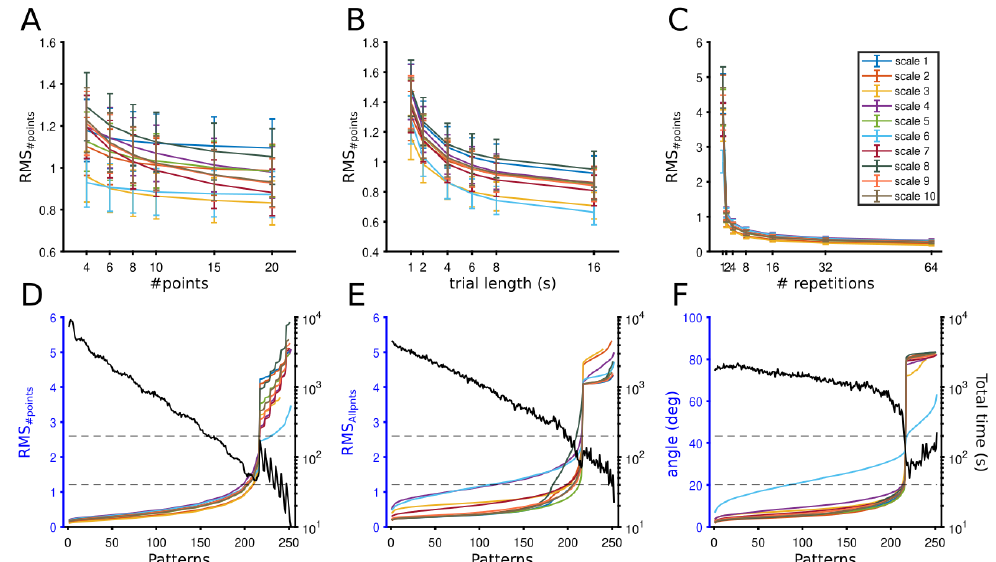
Figure 4. Optimization of fit performance and total experimental time to experimental conditions across metrics (errors). Fit performance as a function of experimental conditions is shown in ( A – C ). Each dot is the average of 300 CRF simulations. Bars represent SEMs. ( A ) RMS #points for a number of points. ( B ) RMS #points for the length of trials. ( C ) RMS #points for a number of repetitions. Sorting of RMS #points ( D ), RMS Allpoints ( E ), and angles ( F ) solutions for combination of all patterns, experimental conditions (left y-axis), against the average total experimental time (black line, right y-axis). Lines are the average of 174 CRF simulations. Dash lines are the range of optimal fit performance and experimental duration.